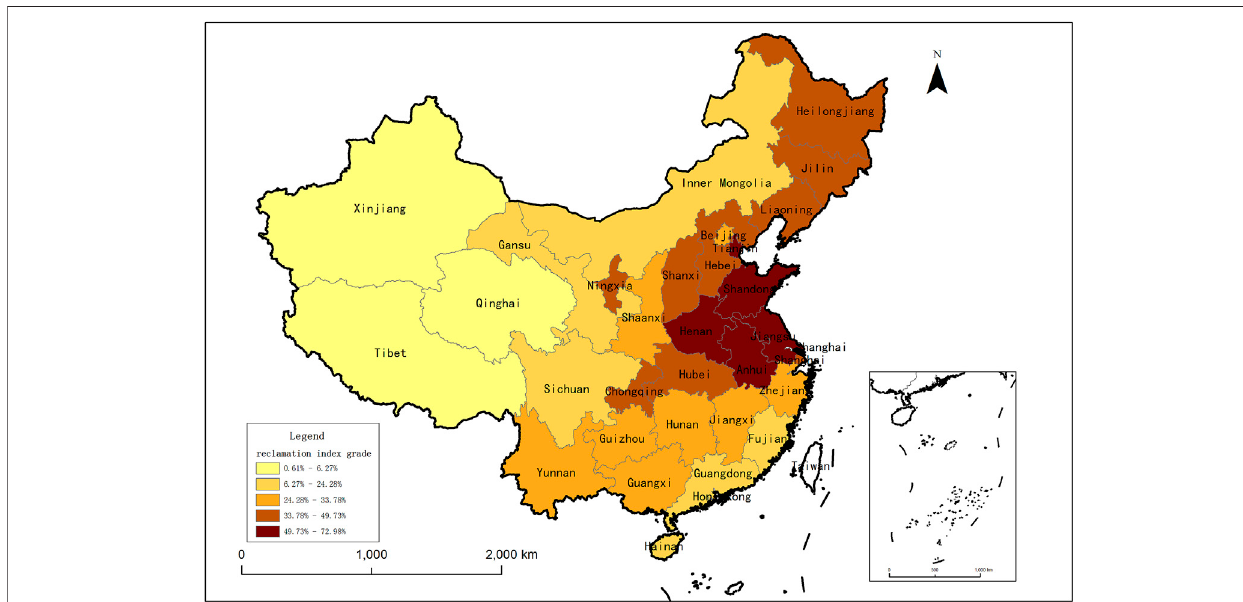
FIGURE 5 | The classi fi cation map of reclamation index of China in 2020.